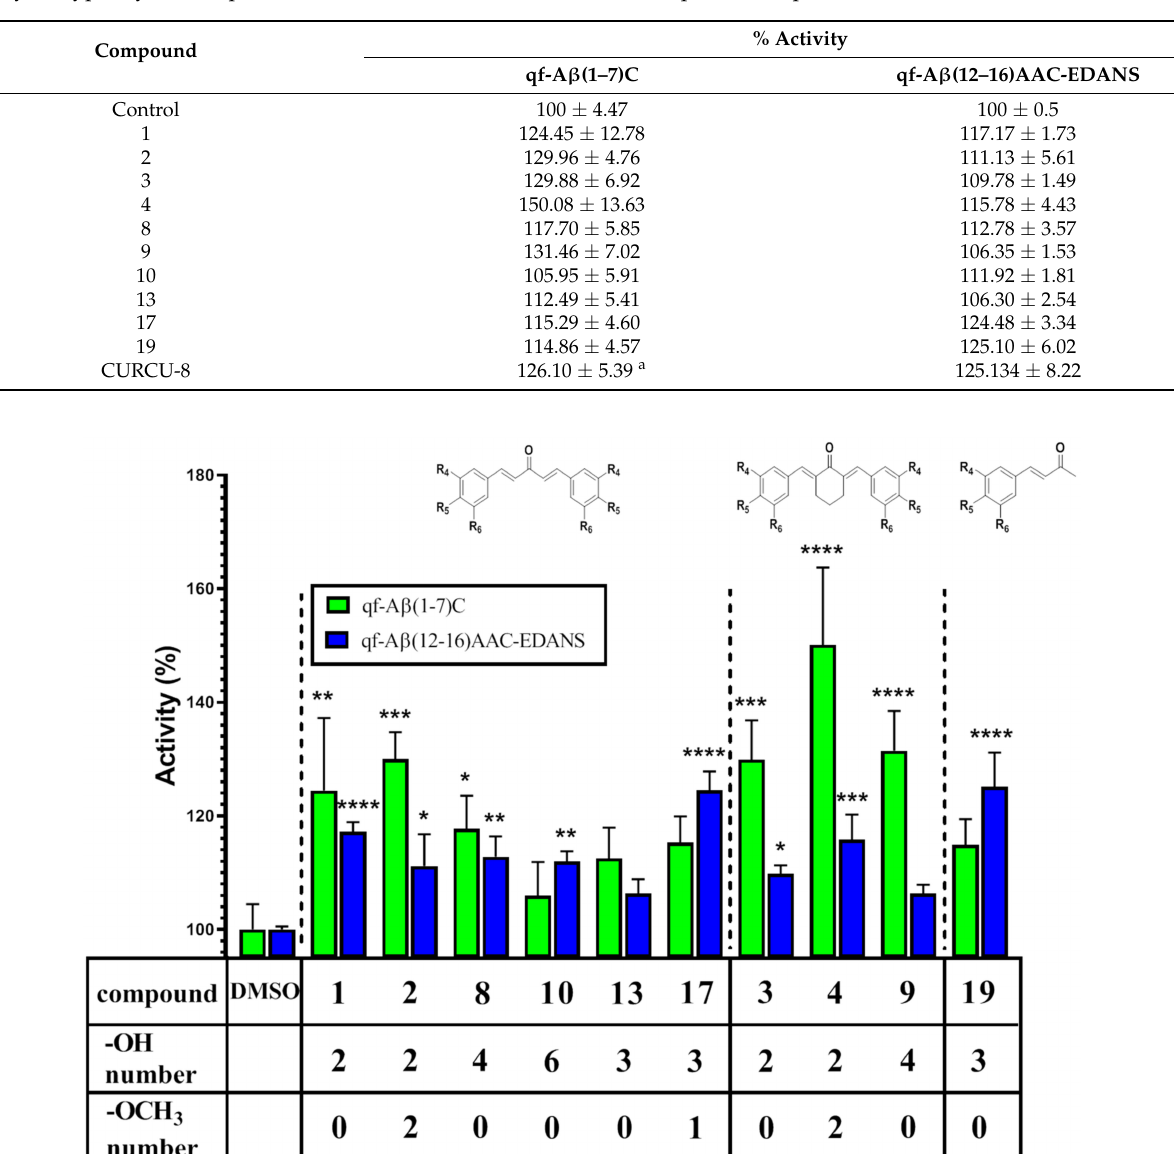
Table 1. Comparison of A β -degrading activity by using qf-A β (1–7)C or qf-A β (12–16)AAC-EDANS. CURCU-8 is 1,7-Bis(3,4-